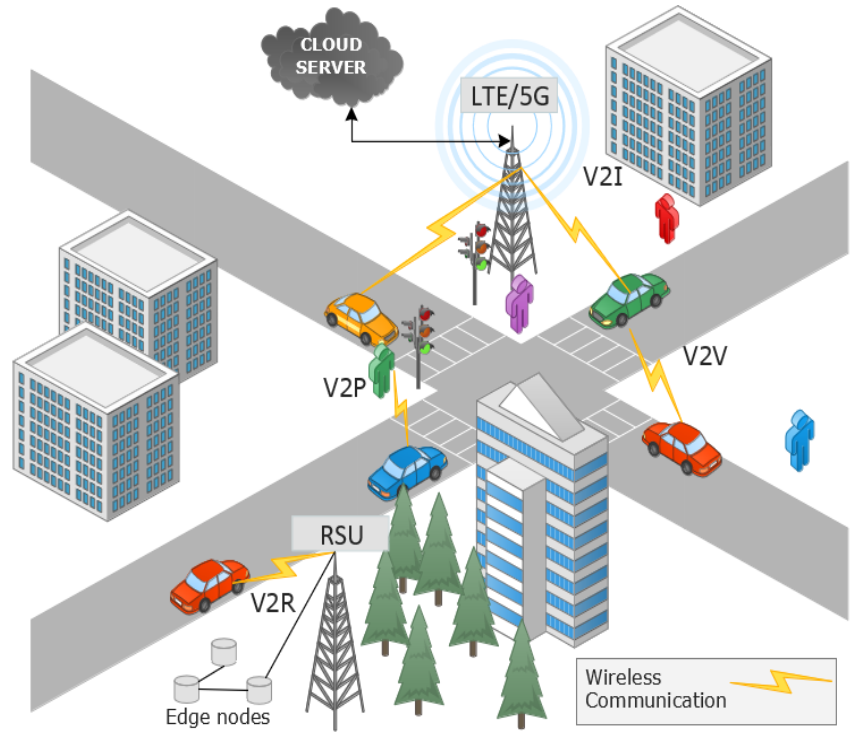
Figure 1. An example of a vehicular network environment.